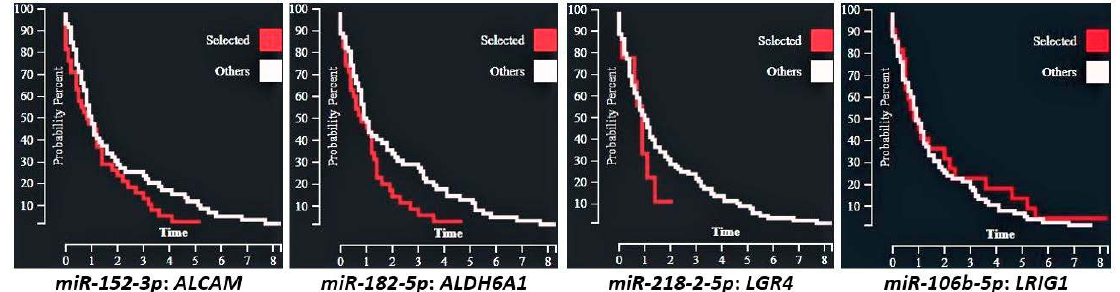
Figure 3. Kaplan − Meyer CRC survival curves for miRNA cases selected by their SC target gene versus all other cases, X-axis =